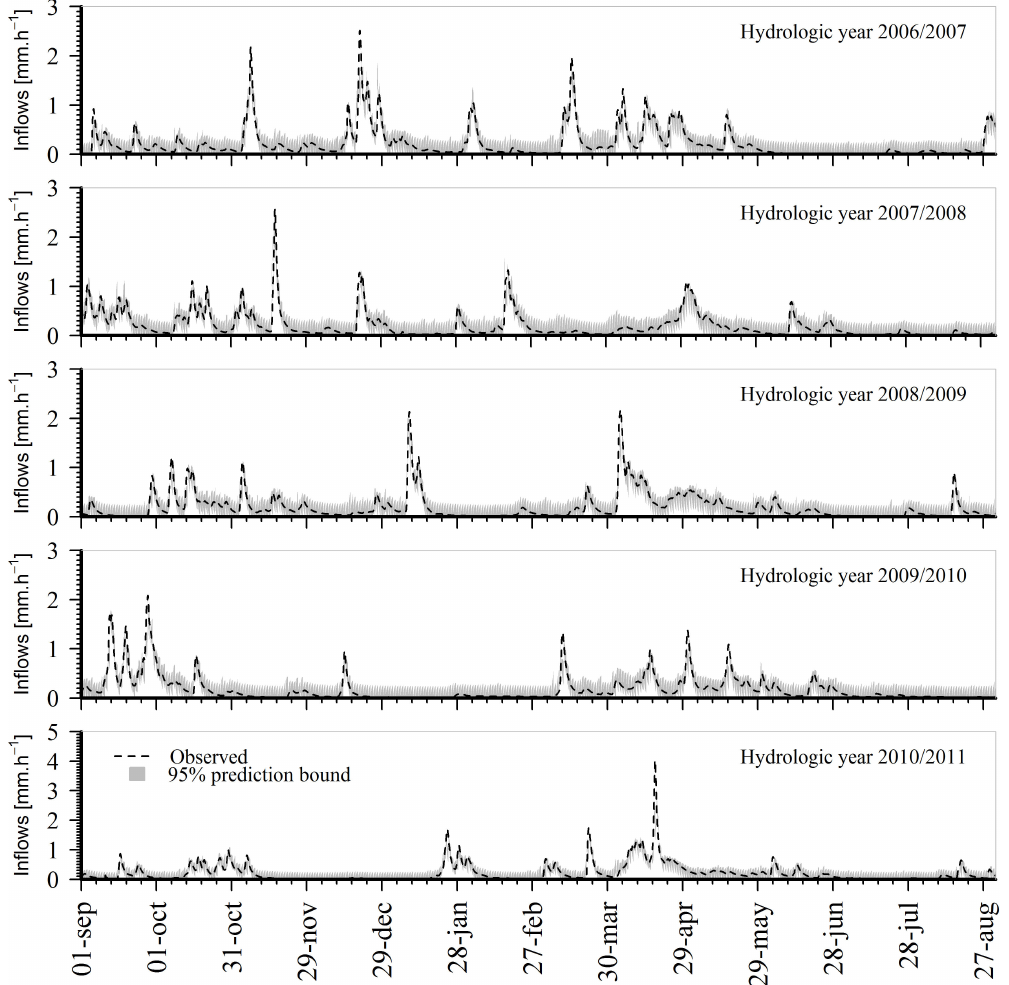
Figure 8. Observed hydrograph (broken lines) and the forecasted 95% confidence